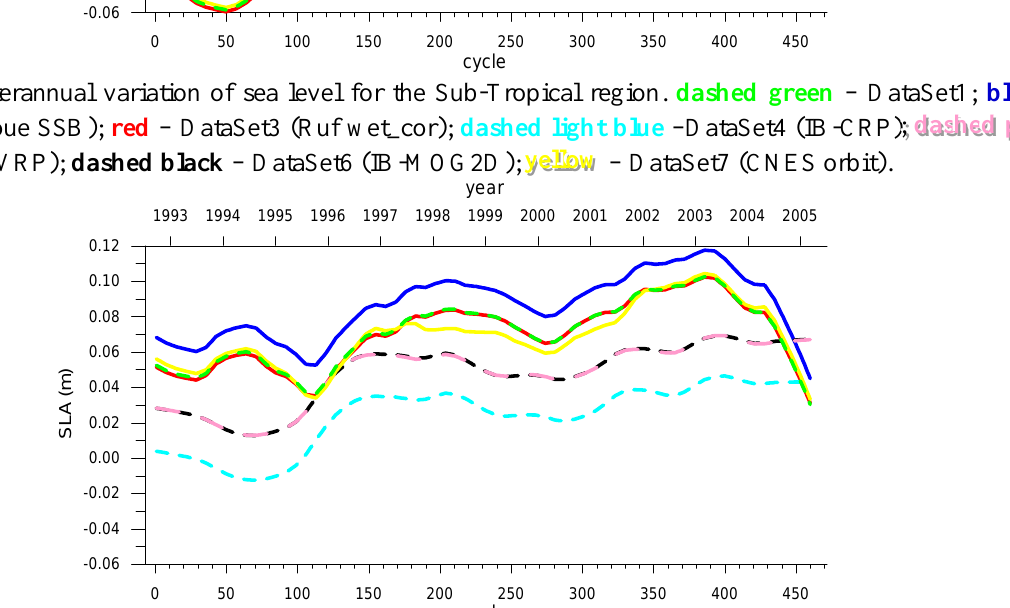
Figure 10c. Interannual variation of sea level for the Sub-Arctic region. dashed green – DataSet1; blue – DataSet2 (Labroue SSB); red – DataSet3 (Ruf wet_cor); dashed light blue –DataSet4 (IB-CRP);;; dddaaassshhheeeddd pppiiinnnkkk – DataSet5 (IB-VRP); dashed black – DataSet6 (IB-MOG2D); yyyeeellllllooowww – DataSet7 (CNES